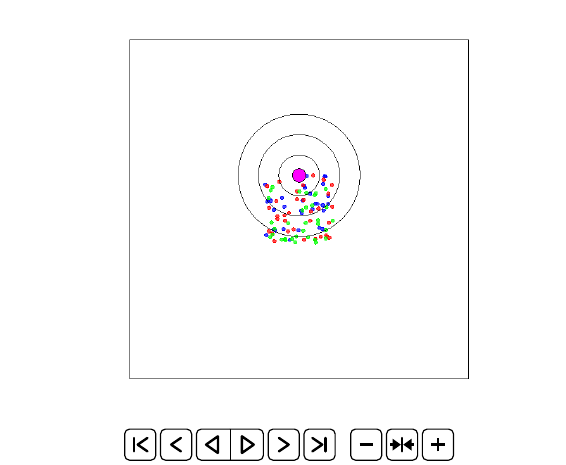
Figure 4. A video simulation when the blood vessel has a fixed location and each zone has a width of three units. Neighborless cells cannot prolifereate: σ = 0. The blue, red, and green represent T + , T P , and T − cells, respectively.